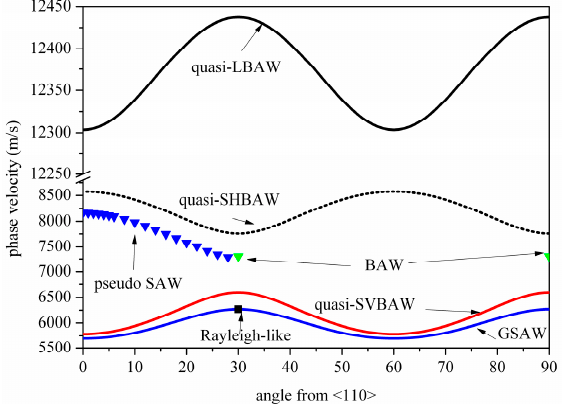
Figure 6. The angular dispersion curves of the SAWs and BAWs propagating along the (111) plane of 3C-SiC.